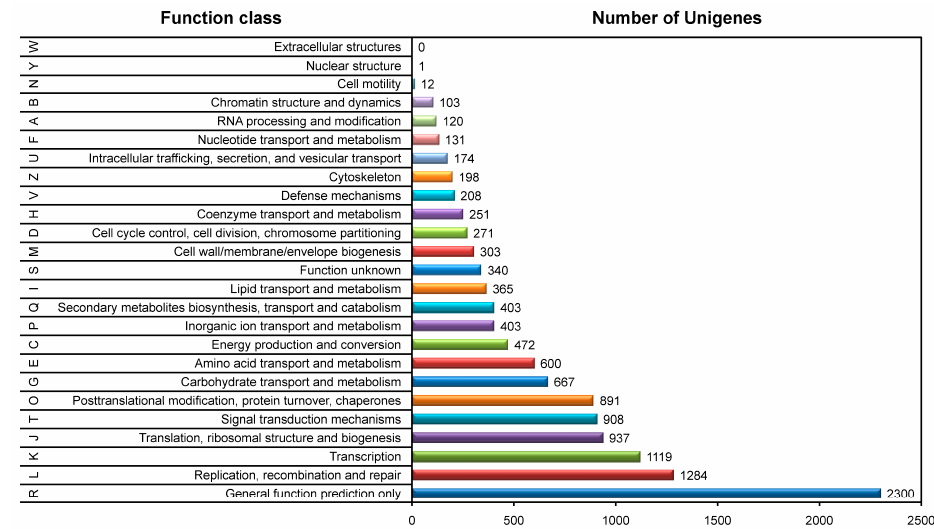
Figure 2. Summary of COG function annotation of assembled tepal transcriptome of Chinese narcissus. In total, 8977 annotated transcripts were assigned to 25 eukaryotic orthologous groups based on sequence similarity. The number of transcripts in each group was labeled.